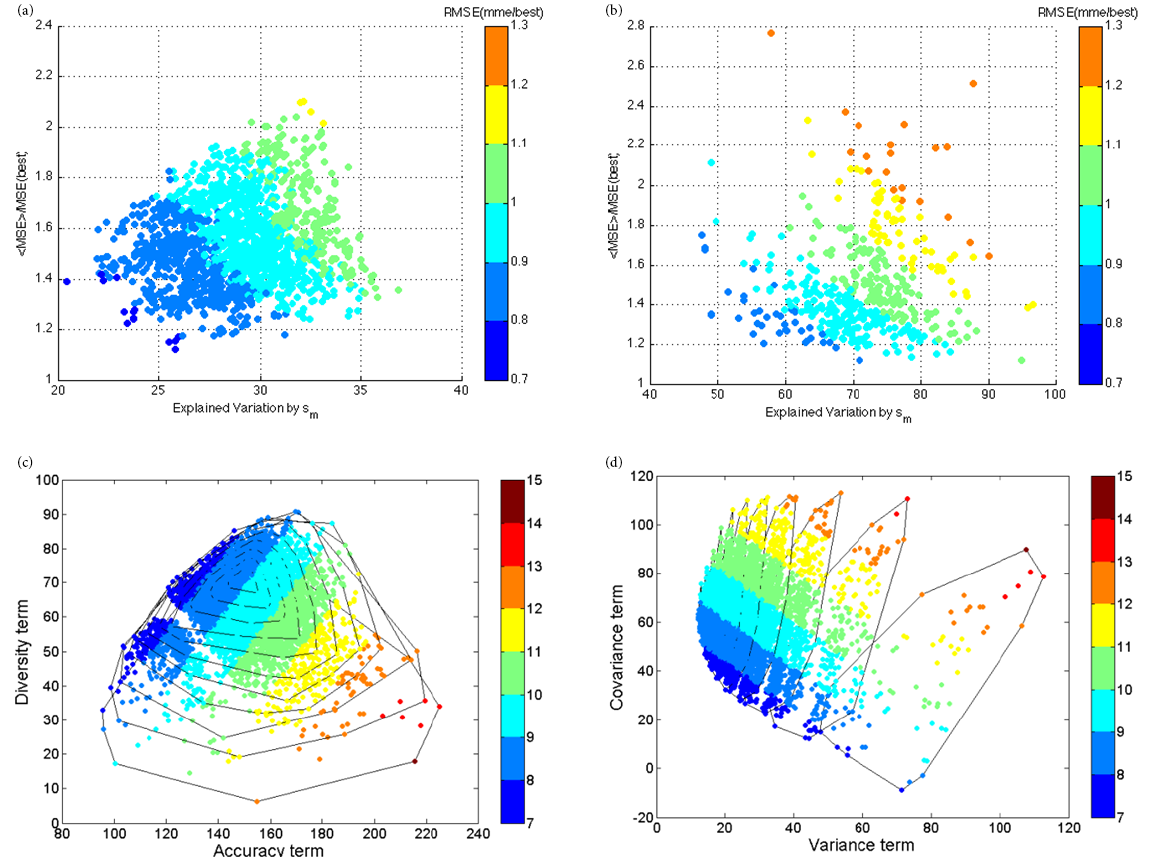
Figure 5. (a, b) The RMSE ratio of mme over the best single model as a function of redundancy (explained variation by the maximum eigenvalue sm) and model skill difference ( < MSE > /MSE(best), evaluated from all combinations of 6th order (top left) and 13th order (top right). The diagram on the right has been evaluated at all observation sites. (c, d) Four-dimensional representation of accuracy–diversity (bottom left) and variance–covariance (bottom right), with respect to RMSE (colour scale) and ensemble order (isolines). The isolines represent the multi-dimensional convex hull as a function of ensemble order. Isolines shrink with increasing ensemble